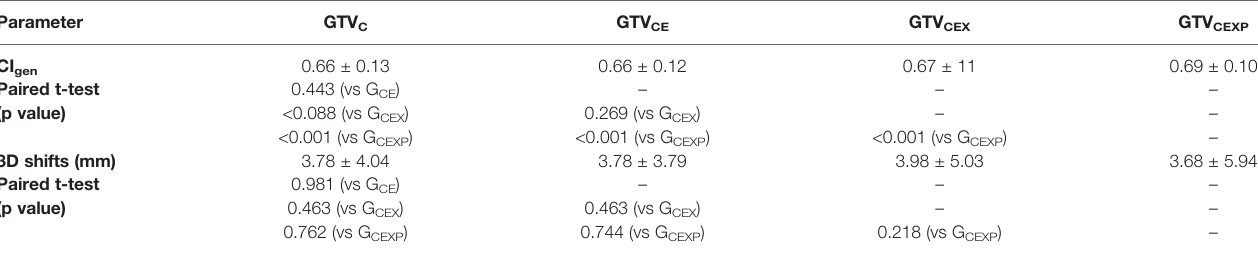
TABLE 5 | The CI gen values and 3D centroid shifts (Mean ± SD) of the fi ve GTVs delineated by different observers based on each combinations of multimodal imaging. Parameter